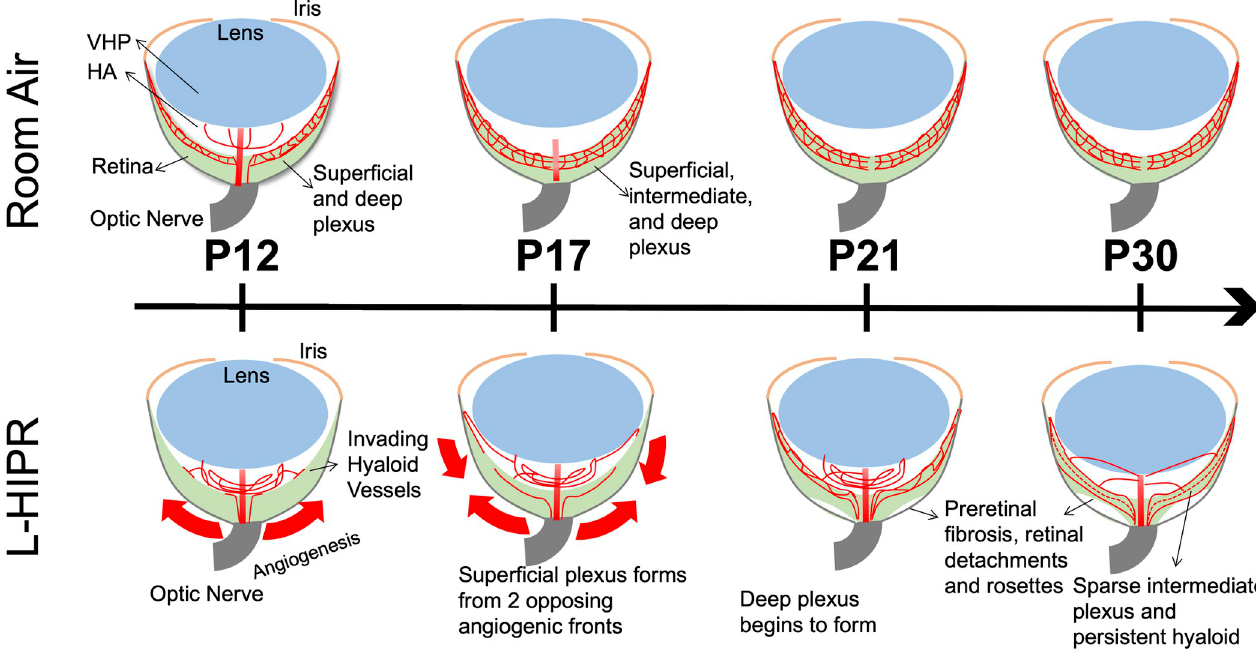
Fig 8. Proposed model for the progression of L-HIPR. Course of retinal vascular development, preretinal fibrosis and hyaloidal rescue of the retinal vasculature during L-HIPR exposure.